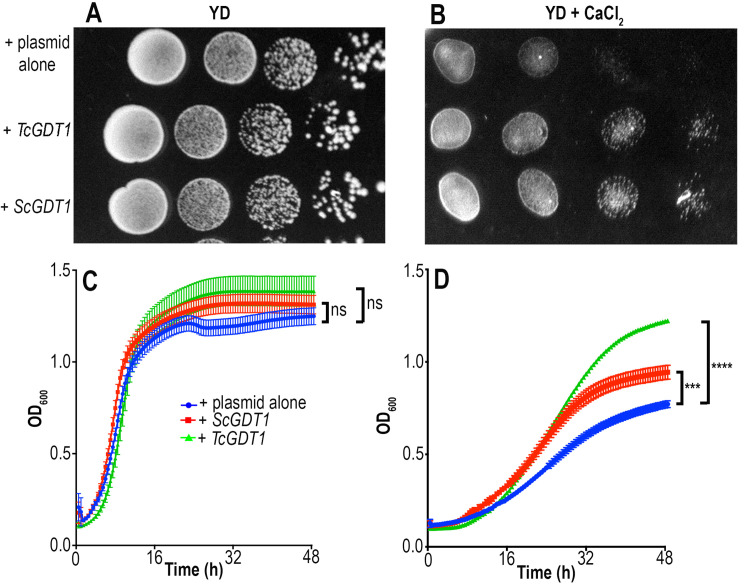
Complementation of yeast GDT1 mutants.(A, B) Growth of S. cerevisiae GDT1 null mutant (gdt1Δ) transformed with empty plasmid, or complemented with ScGDT1, or TcGDT1 chimera, and precultured in YD medium to an OD600 of 0.1. Serial 10-fold dilutions were dropped onto solid YD medium alone (A) or supplemented with 750 mM CaCl2 (B). (C-D) Growth of the cultures in liquid YD medium alone (C) or supplemented with 750 mM CaCl2 (D) starting at OD600 of 0.1 was monitored every 30 min for a total period of 48 hours. Data is representative of three biological replicates, each with five technical replicates. Values are means ± s.d., n = 3; n.s, no significant difference, ***p < 0.005, ****p < 0.001. Statistical analyses were performed using one-way ANOVA and Turkey’s multiple comparisons test.